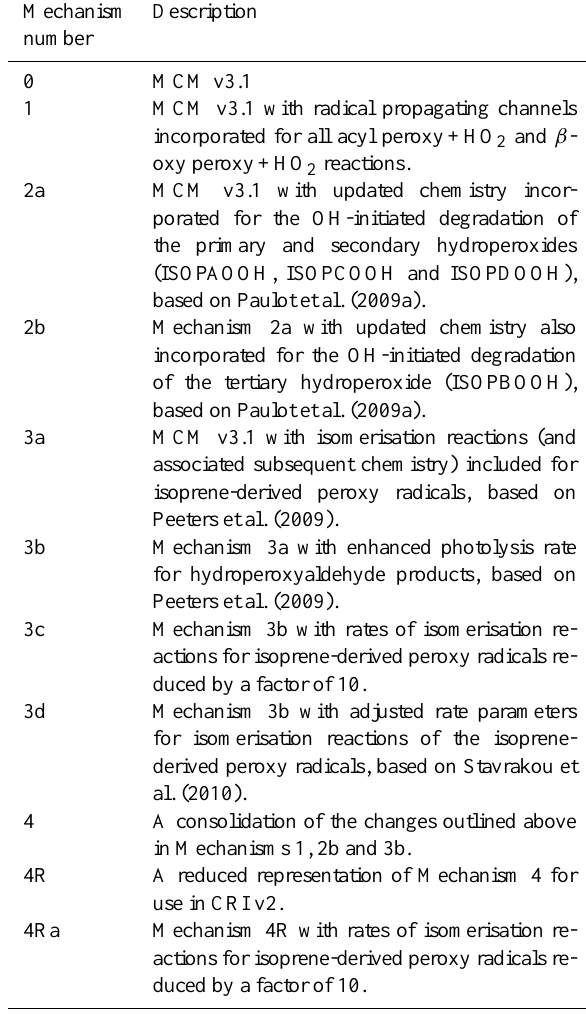
Table 1. Description of main mechanistic sensitivity runs per- formed (see Sects. 3.2–3.4 and